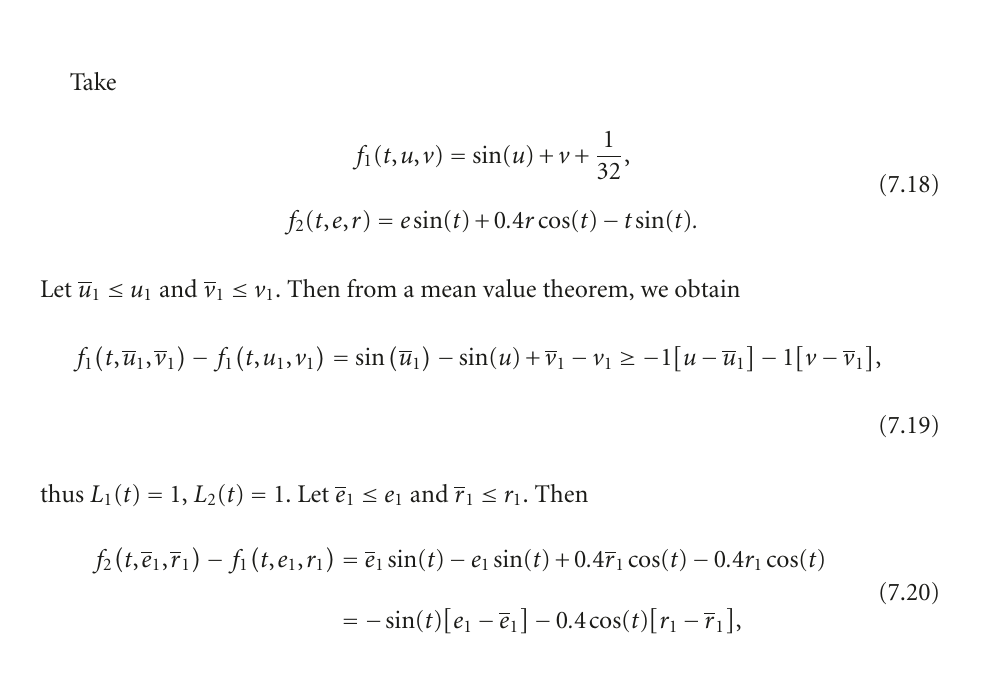
Figure 7.1. Iterations number 6 and